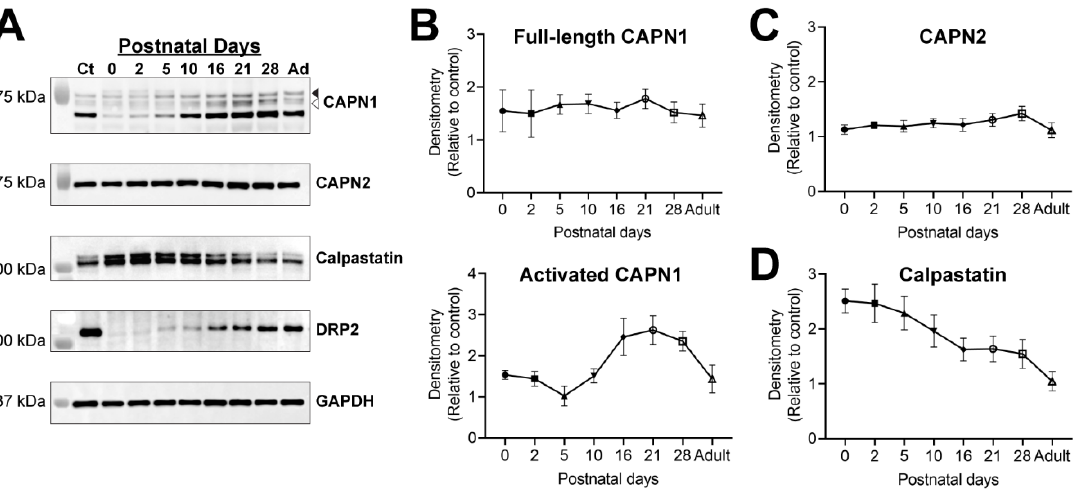
Figure 1. Calpain and calpastatin expression in rat sciatic nerves during development. ( A ) Im- munoblotting representative images from the day of birth (P0) until adult. Relative levels of full- length CAPN1 (arrowhead at 80 kDa), amino-processed CAPN1 (open arrowhead at 76/78 kDa), CAPN2, and calpastatin were examined. A representative blot of dystrophin-related protein 2 (DRP2) is shown to demonstrate the progression of myelination during development, and GAPDH was examined as an internal loading control. Ct is a common pooled homogenate from post-weaning and adult rats for between blot comparisons. Some molecular weight markers were overlaid to